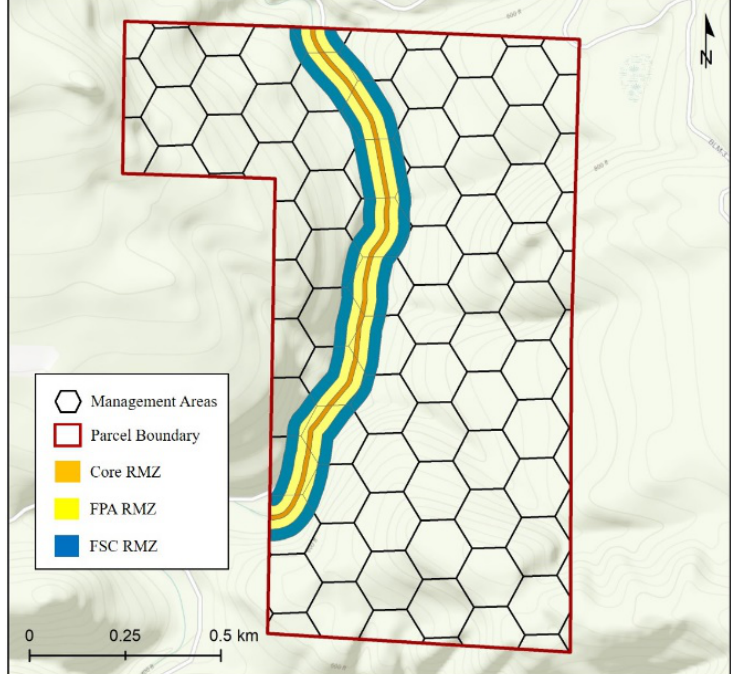
Figure 2. Each parcel is sub-divided into 2.02 hectare (5 acre) ‘stands’, which are then intersected with Riparian Management Zones (RMZs) to form distinct management units that are simulated individually. The parcel above shows the core and non-core RMZ areas delineated following FSC rules.